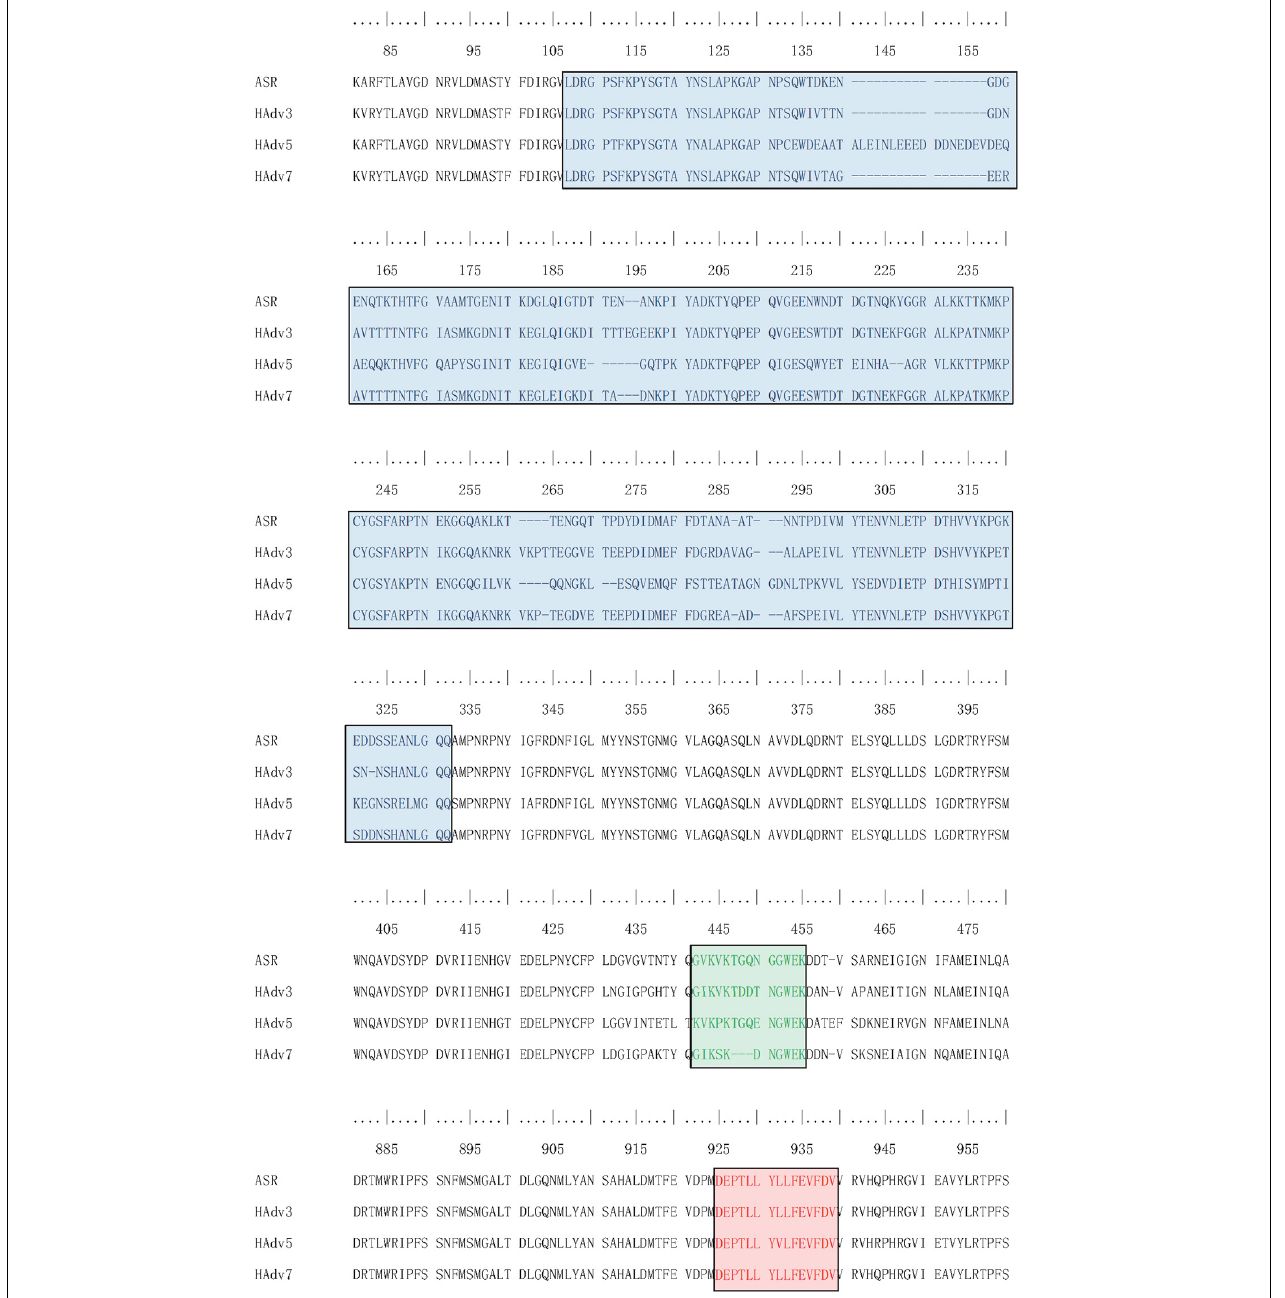
FIGURE 4 | Sequence Alignment of peptides and proteins synthesized for ELISA. Sequences boxed in Blue were expressed as antigen protein segments, named as ASR, ADV3, ADV5 and ADV7; Sequences boxed in Green were synthesized as antigen peptides, named as ASR, ADV3, ADV5 and ADV7; Sequences boxed in Red were synthesized as antigen peptides, named as